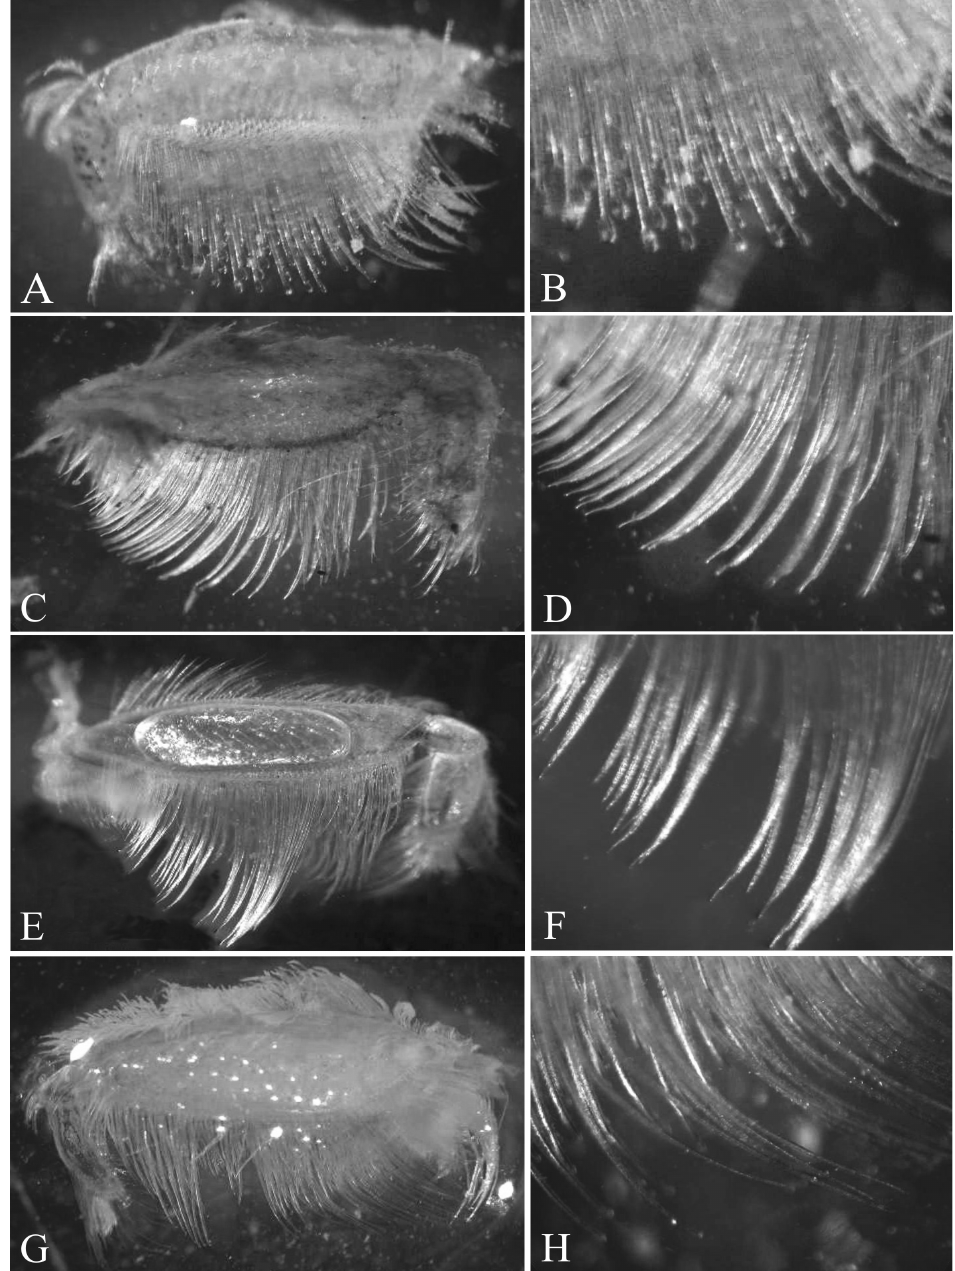
Fig. 4. – Dorsal view of the second maxilliped. A) U. leptodactyla; B) Detail of the setae. Maxilliped width: 2 mm. C) U. rapax; D) Detail of the setae. Maxilliped width: 5 mm. E) U. thayeri; F) Detail of the setae. Maxilliped width: 8 mm. G) U. maracoani; H) Detail of the setae. Maxilliped width: 10